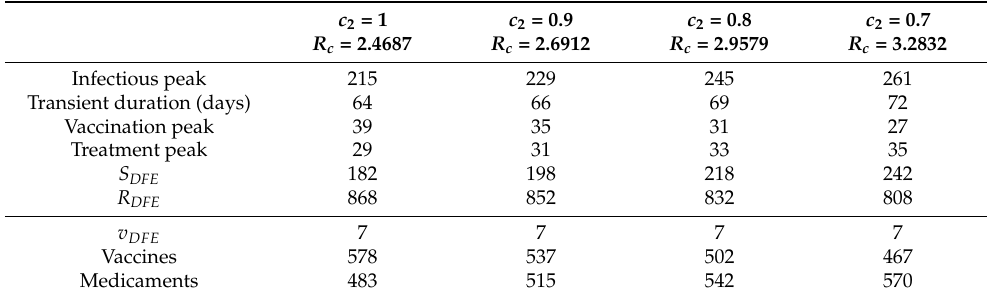
Table 1. Specifications of the model behaviour for the four considered values of the parameter c 2